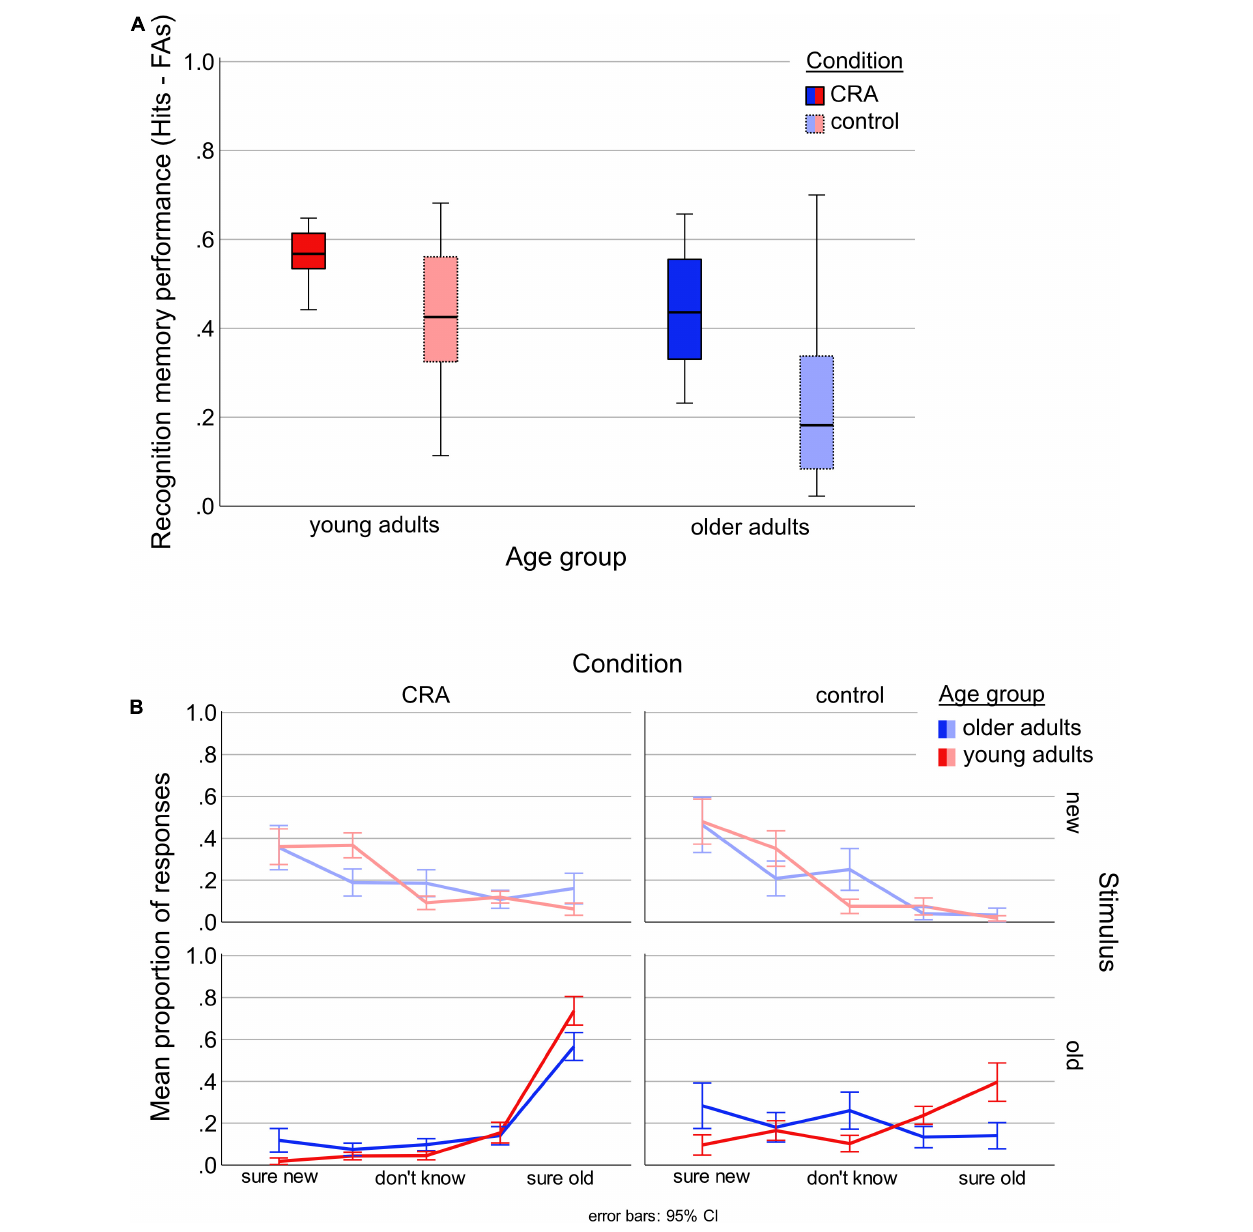
FIGURE 5 | Recognition memory performance. (A) Depicts the ability to discriminate between old and new items (proportion of hits minus false alarms) by Condition (solvable CRA, unsolvable control) and Age group (young, older). (B) Shows the mean proportion of each response category for the recognition memory rating [sure new (–2), probably new (–1), don’t know (0), probably old (1), sure old (2)] by Condition (CRA, control), Stimulus (old, new), and Age group (young,